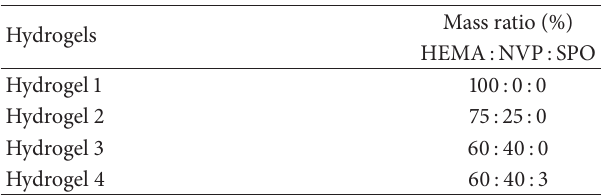
Table 1: Composition of initial reaction mixtures used for the preparation of polymer